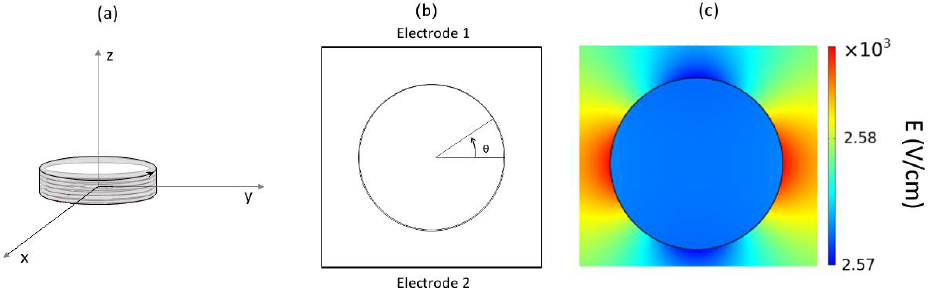
Figure 1. Schematic view of the 3D geometry of the source of the time-varying magnetic field ( a ), of the 2D geometry ( b ), and of the spherical cell placed in an extra-cellular medium and the 2D electric field distribution ( c ). Table 1. Dielectric properties of cell regions.